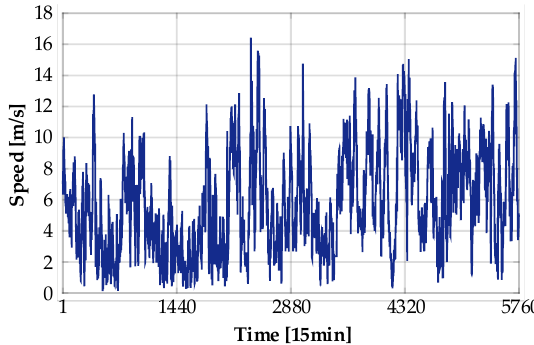
Figure 3. Actual wind speed data in September and October of 2015.